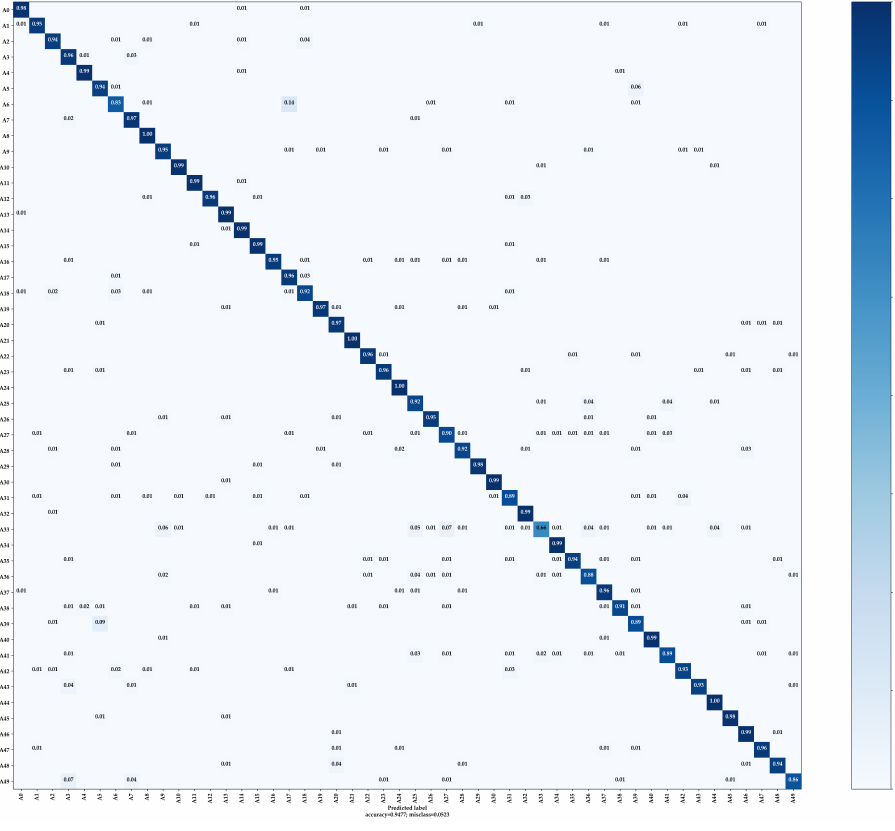
Figure 14. Confusion matrix of our P 2 FEViT (ViT-S/ResNet50) on BIT-AFGR50 (train:test =